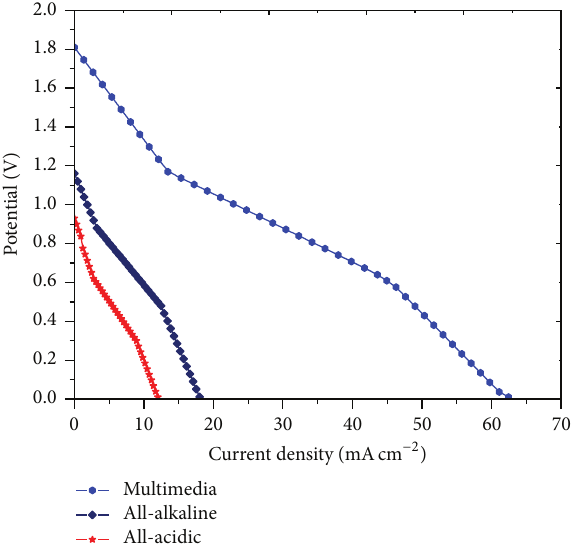
Figure 4: Power density curves for overall cell performance of MLSPBFC operating in alkaline (0.5 M NaOH), acidic (0.5M H 2 SO 4 ), and mixed-media (anode: 0.5 M NaOH and cathode: 0.5 M H 2 SO 4 ) at room temperature. For all experiments the fuel stream is 2 M formic acid, and the oxidant stream is 0.1M perborate in the respective media. Stream flow rates: 0.3 mL min −1